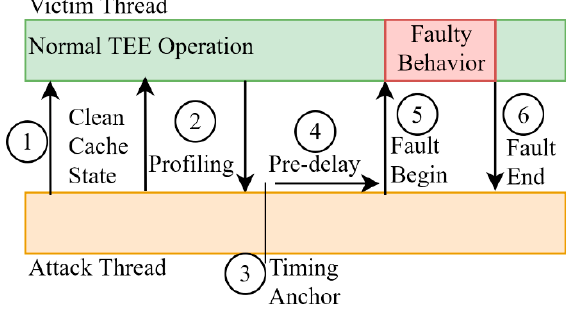
Figure 16. The CLKscrew attack.